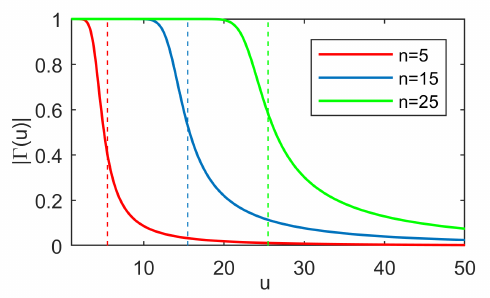
Figure 9. Generalized reflection coefficient of TM nm mode for n = 5,15, and